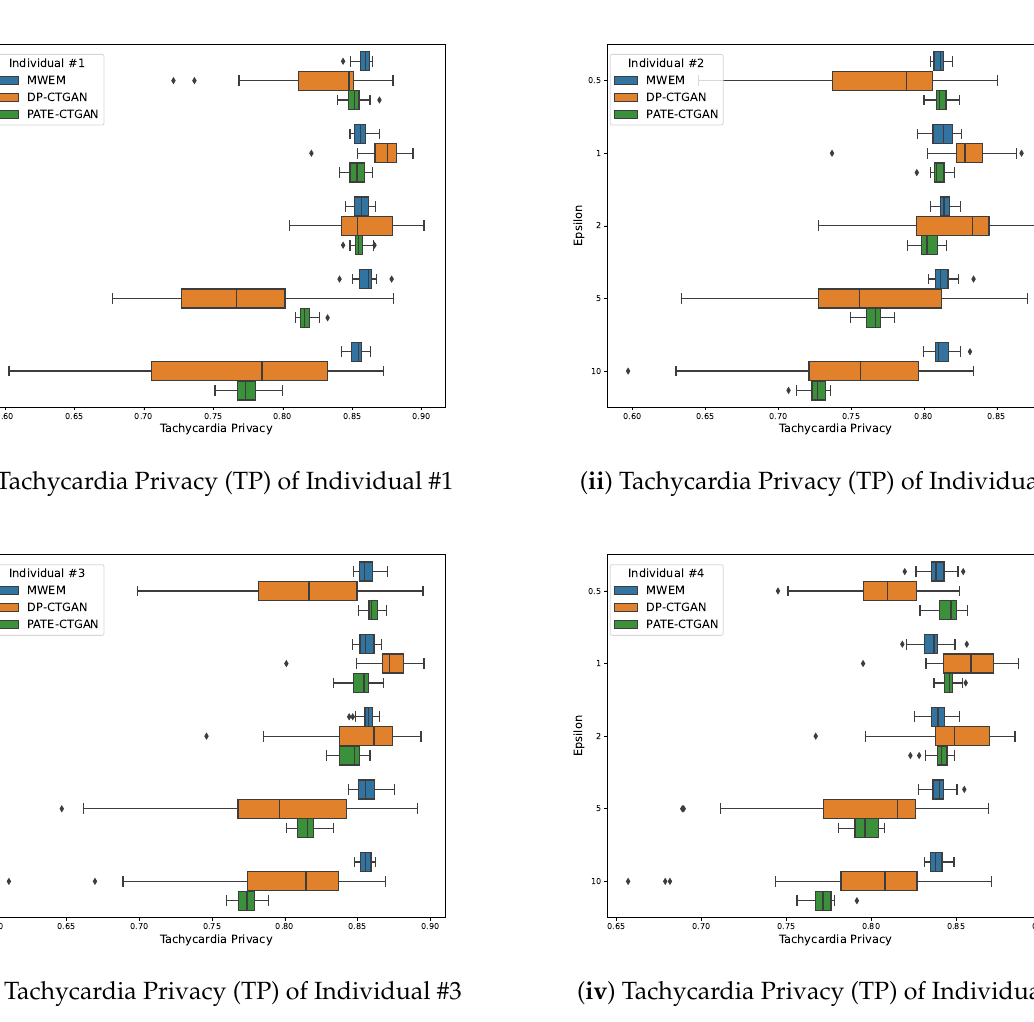
Figure 3. Box plots showing the Tachycardia Privacy (TP) for four individuals using MWEM, DP-CTGAN, and PATE-CTGAN at 20